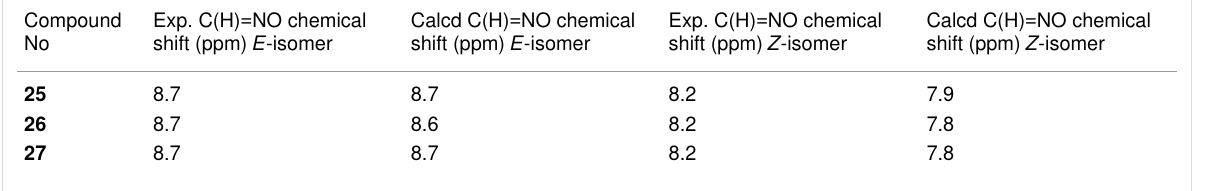
Table 1: Calculated 1 H chemical shifts for C(H)=NO proton vs experimental values. (Exp. = experimental, Calcd = calculated). Compound No